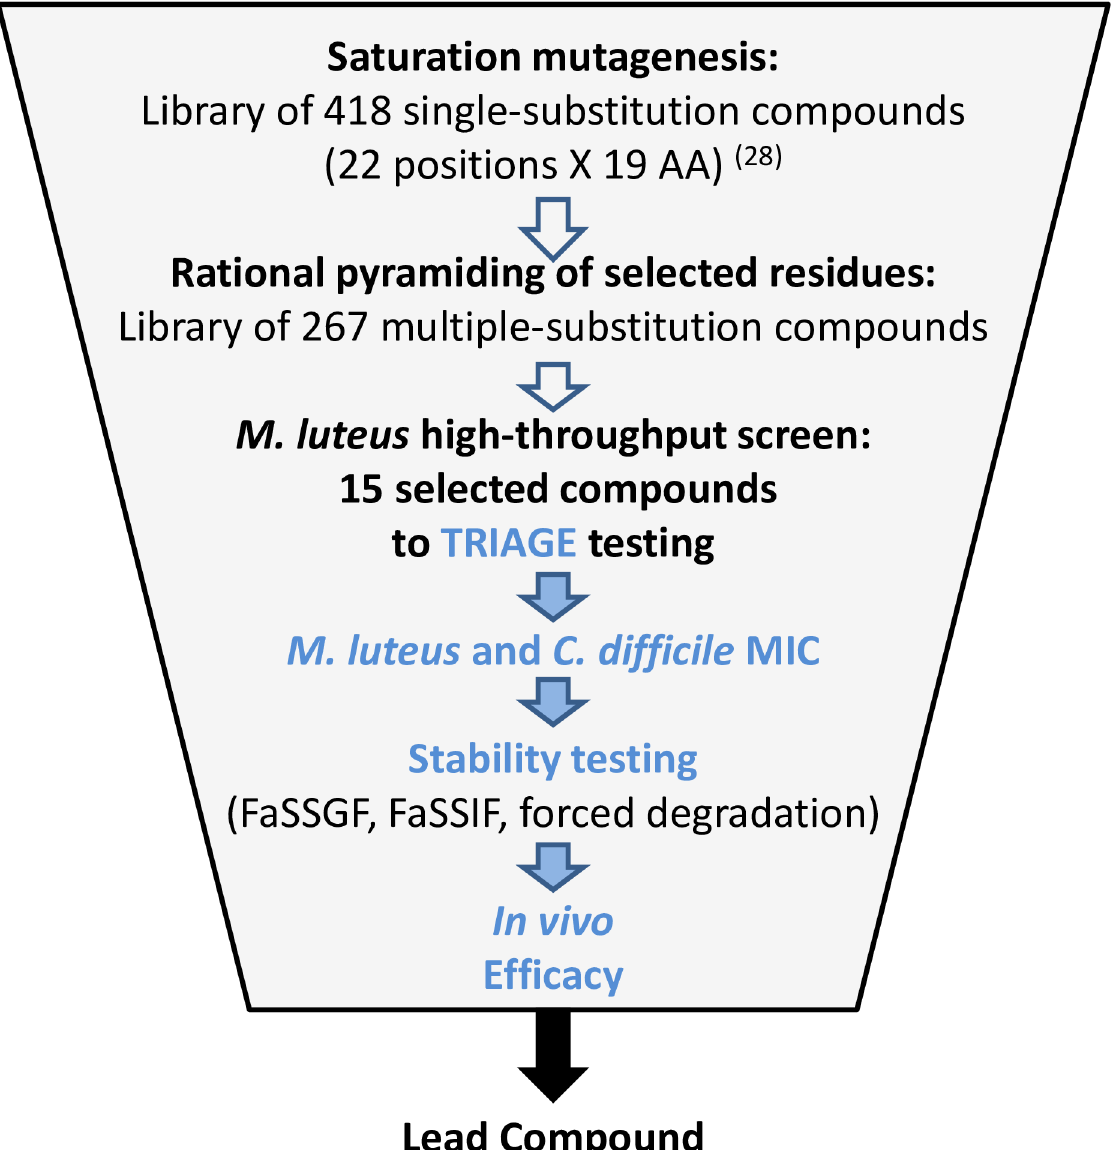
Fig 2. Triage strategy used in this study. High-throughput activity screening used robotic spotting and an optical scanner for the determination of the zones of inhibition. MIC testing provided specific activity values for the determination of the potency. Stability testing performed using biologically-relevant substrates. In vivo efficacy performed in the Golden Syrian hamster model of CDAD. See Materials and Methods section for details. Legend: FaSSGF, fasted-state simulated gastric fluid; FaSSIF, fasted-state simulated intestinal